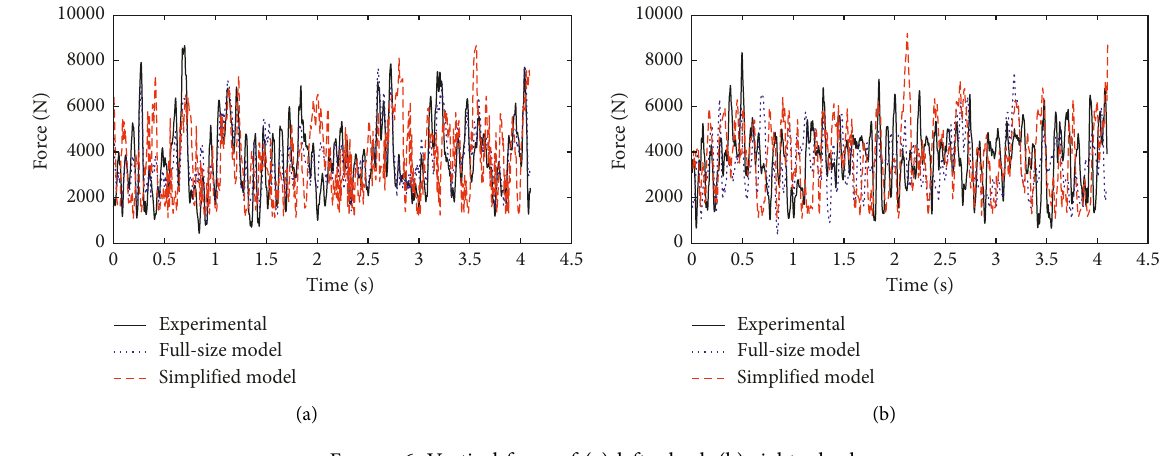
Figure 6: Vertical force of (a) left wheel; (b) right wheel. Table 2: Statistics characteristics for vertical wheel force histories.